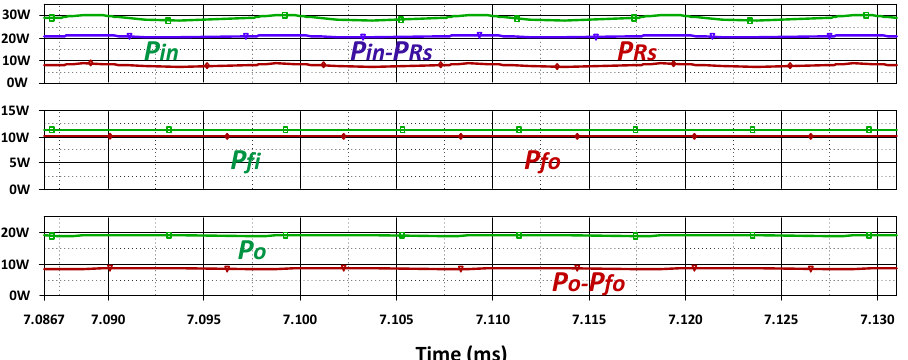
Time (ms) Figure 13. Simulation results. Input power ( P in ), power consumed by R s ( P Rs ), and power delivered Figure 13. Simulation results. Input power ( P in ), power consumed by R s ( P Rs ), and power delivered Figure 13. Simulation results. Input power ( P in ), power consumed by R s ( P Rs ), and power delivered Figure 13. Simulation results. Input power ( P in ), power consumed by R s ( P Rs ), and power delivered by the TEGs ( P in -P Rs ); input and output power of the flyback converter ( P fin , P fo ); output power ( P o ) by the TEGs ( P in -P Rs ); input and output power of the flyback converter ( P fin , P fo ); output power ( P o ) by the TEGs ( P in -P Rs ); input and output power of the flyback converter ( P fin , P fo ); output power ( P o ) by the TEGs ( P in -P Rs ); input and output power of the flyback converter ( P fin , P fo ); output power ( P o ) and power that is delivered directly to the load ( P o - P fo ). and power that is delivered directly to the load ( P o - P fo ). and power that is delivered directly to the load ( P o - P fo ). and power that is delivered directly to the load ( P o - P fo